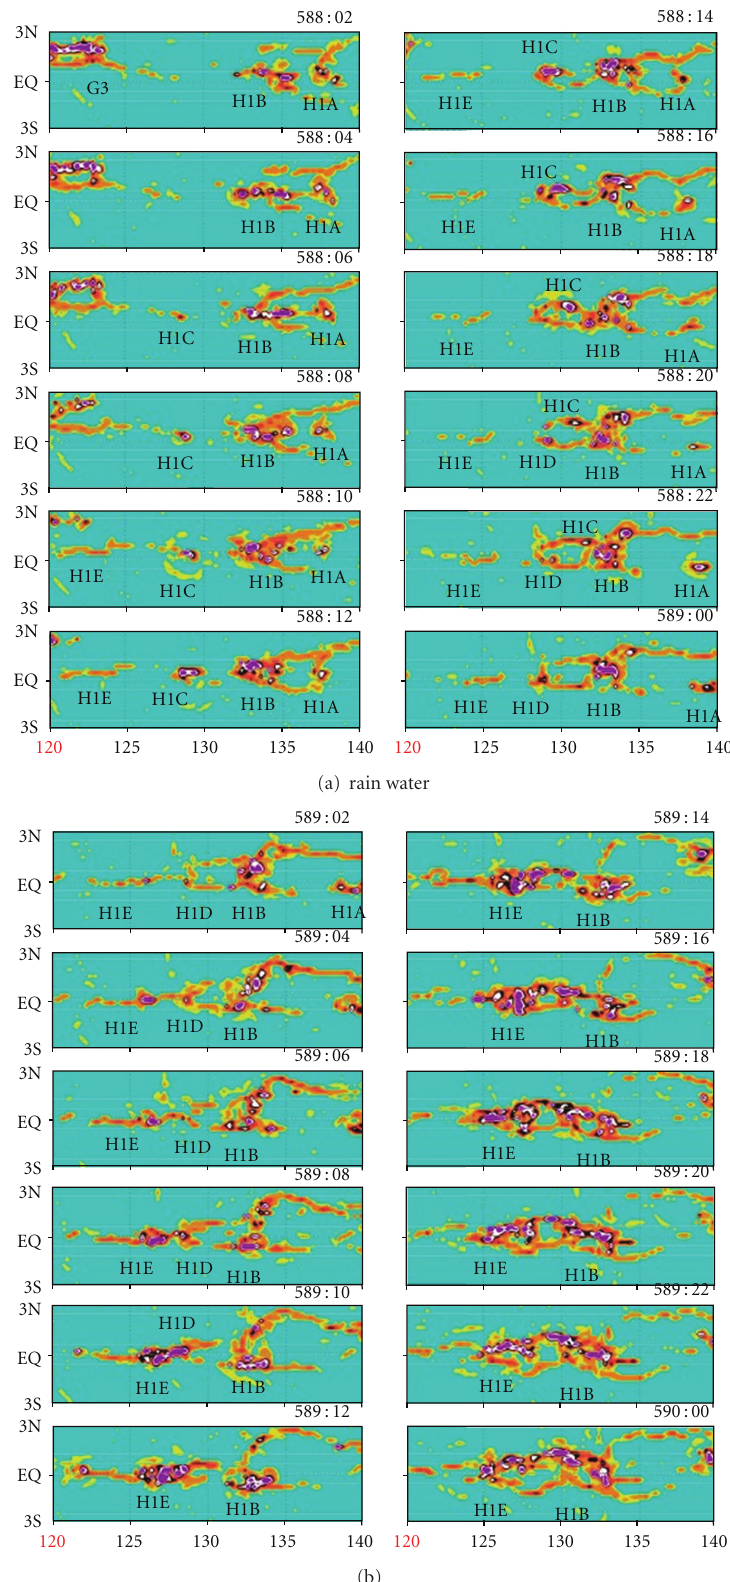
Figure 9: Horizontal distribution of the low-level rainwater mixing ratio in case (R) at a time interval of 2 hours: (a) from 588 day 02 hour to 589 day 00 hour and (b) 589 day 02 hour–590 day 00 hour. Each of mesoscale convective systems, which constitute cloud cluster H1, is labeled by H1A, H1B, ... , and